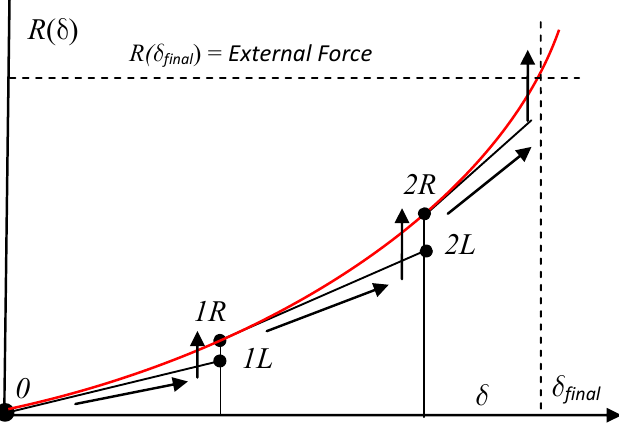
Figure 4. Scheme of the iterative procedure with the Newton–Raphson method.